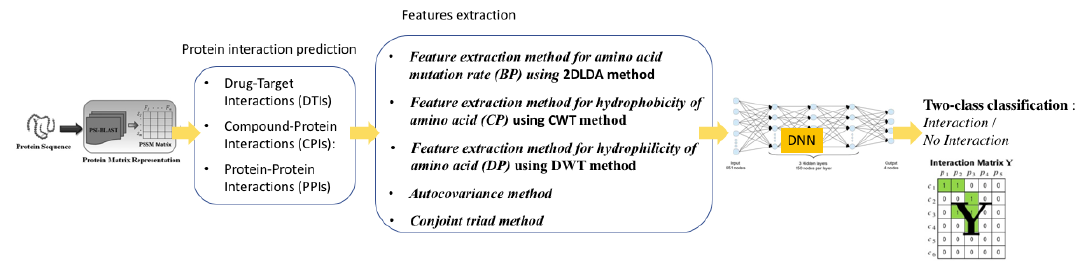
Figure 10. Protein Interaction Prediction